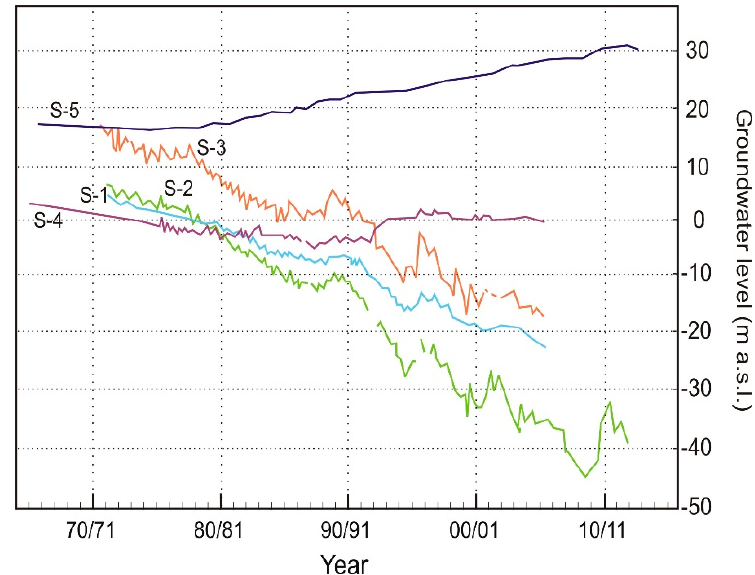
Figure 4. Hydrographs in some wells in the Campo de Dalías (see location in Figure 2). The selected wells are representatives of different sectors in the study area, allowing to know the groundwater level trends in each